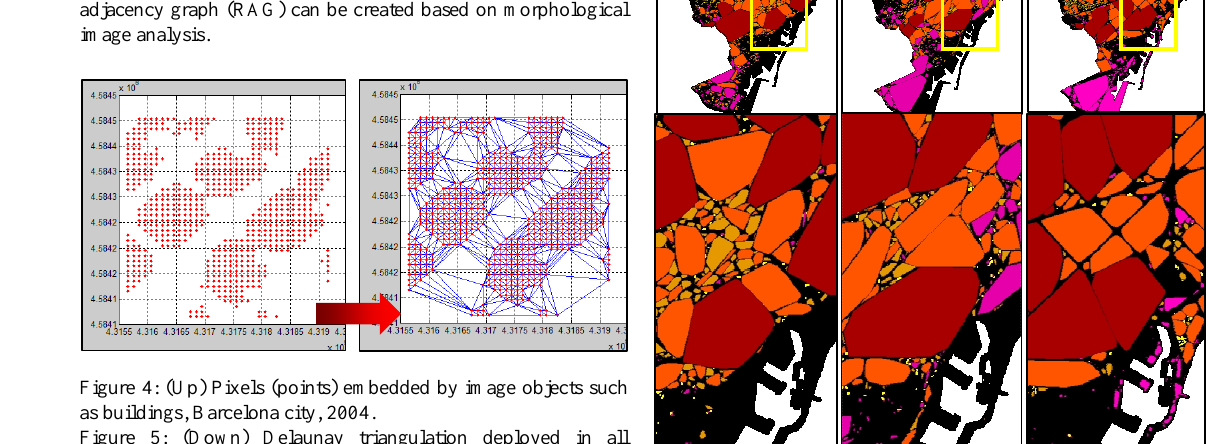
Figure 9: Multi-temporal clustered classification